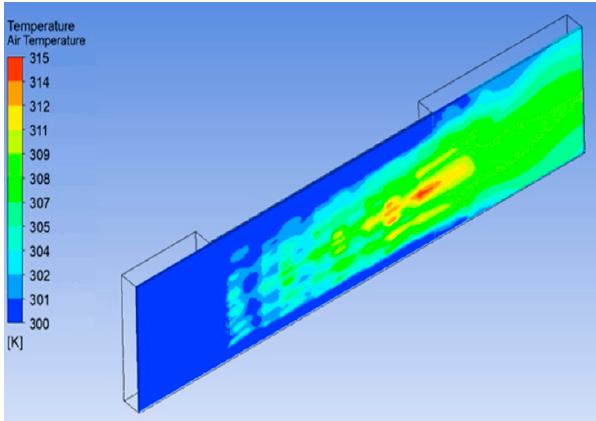
Figure 8. Air temperature profile near the battery modules.